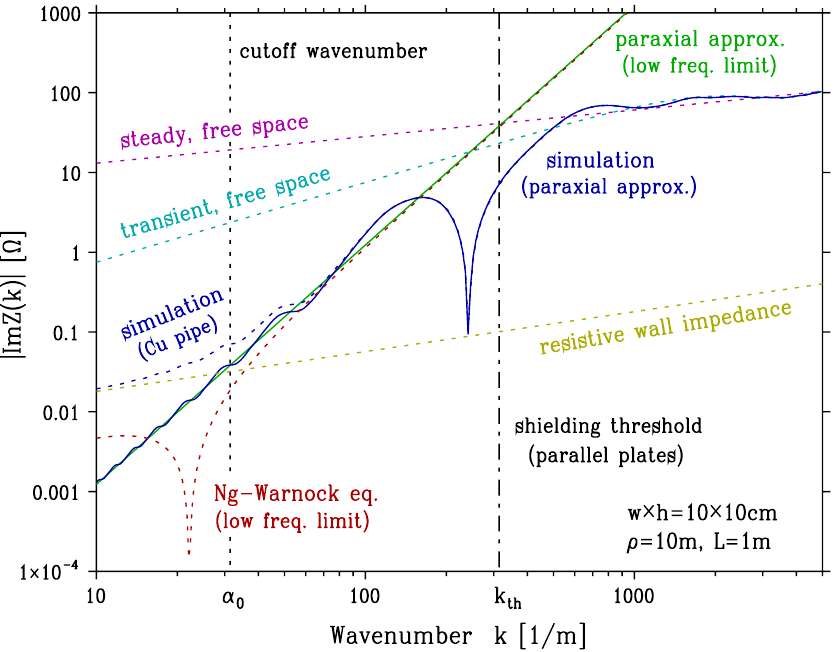
¼ 1 and FIG. 6. (Color) Imaginary impedance in the low frequency limit. We assume a thin beam of ultrarelativistic particles, i.e., (cid:3) p (cid:5) ¼ 1 . The green line is the asymptotic expression of Eq. (90), and the red dashed line shows Eq. (87). The blue solid line represents the simulation result using the parabolic equation in the paraxial approximation [11], where we set the magnet length to 1 m and assume a perfectly conducting pipe. The most realistic case is shown by the blue dashed line which is the impedance in a copper square pipe, obtained by simulation [12]. The chamber width and the height are w (cid:11) h ¼ 10 cm (cid:11) 10 cm , and the bending radius is (cid:3) ¼ ¼ (cid:2)=h , and the dot-dashed vertical line is the threshold wave 10 m . The dashed vertical line is the vertical cutoff wave number (cid:13) 0 . We draw also the CSR impedance in free space: the steady CSR of Eq. (79) is shown by the magenta dashed line and the number k th transient state [8] by the cyan dashed line. The brown dashed line is the resistive wall impedance [18] due to a copper round pipe which is straight and has a diameter of 10 cm. (It is shown that the longitudinal resistive wall wakefield at the center of a square pipe is equal to the one at the center of a round pipe which is inscribed in the square